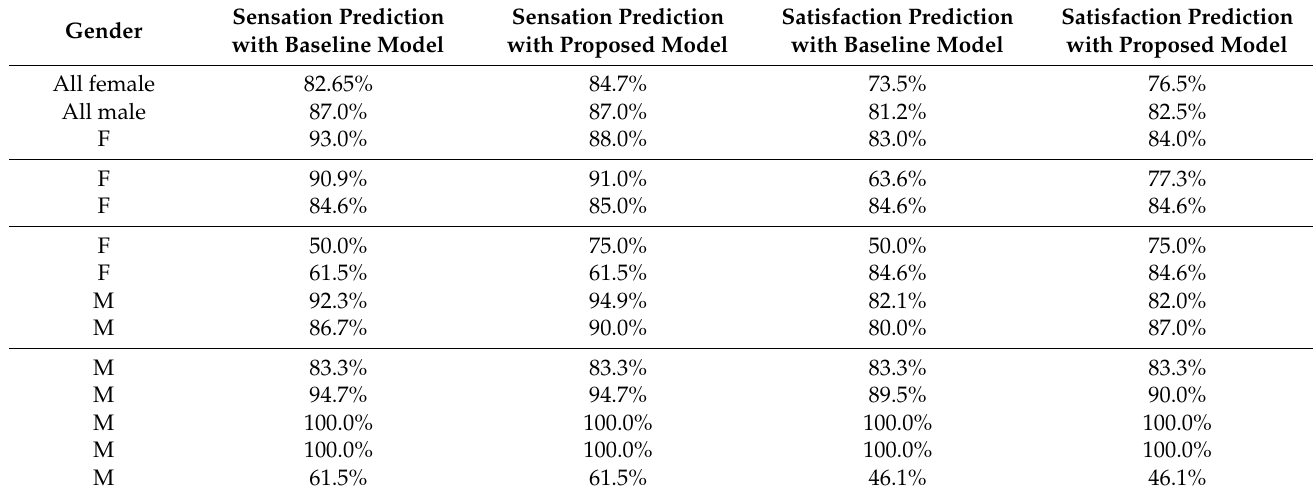
Table 3. Performance benchmark of the thermal models with recall